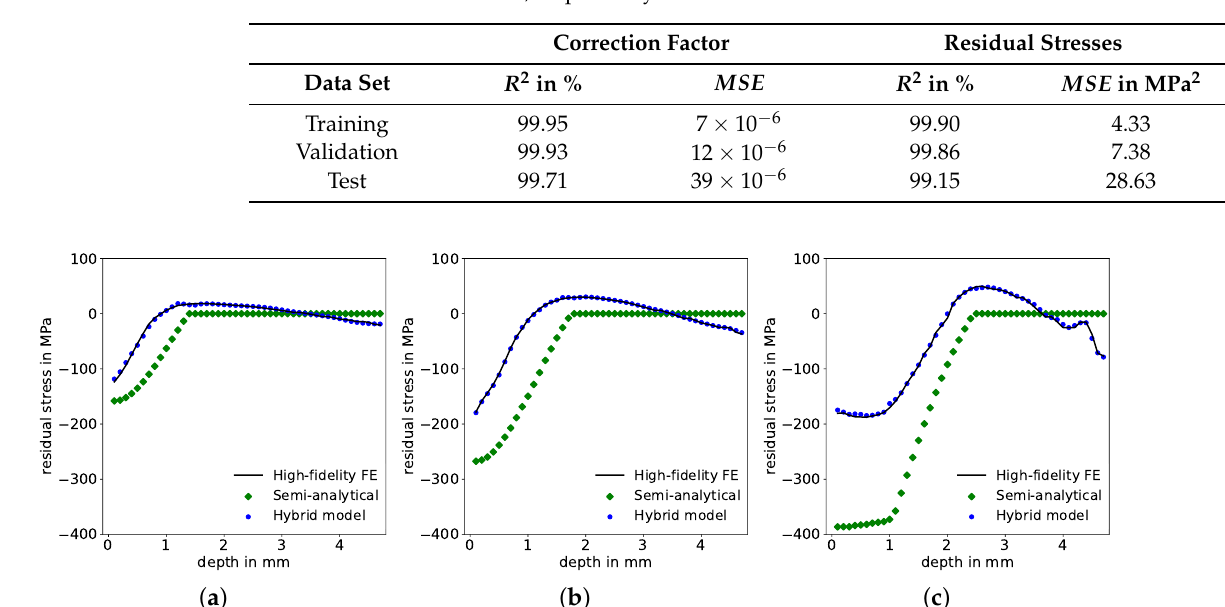
Figure 10. Comparison of residual stress distributions over depth predicted by the FE model, semi-analytical model and hybrid model for three test samples with maximum pressure P max , time of maximum pressure t I and pulse duration t II of ( a ) 1144 MPa, 38.9 ns, 137 ns; ( b ) 1390 MPa, 22.2 ns, 140 ns; and ( c ) 2039 MPa, 49.5 ns, 243 ns,